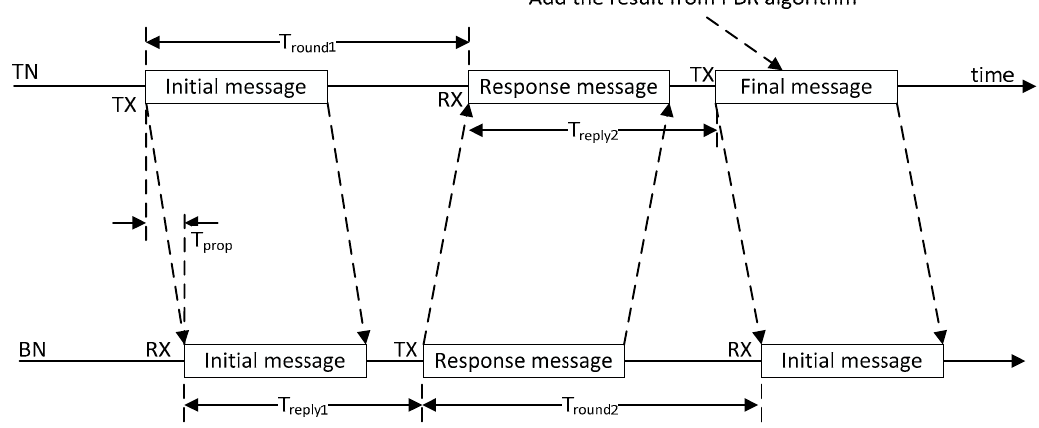
Figure 2. Three messages of double-sided two-way ranging (DS-TWR).